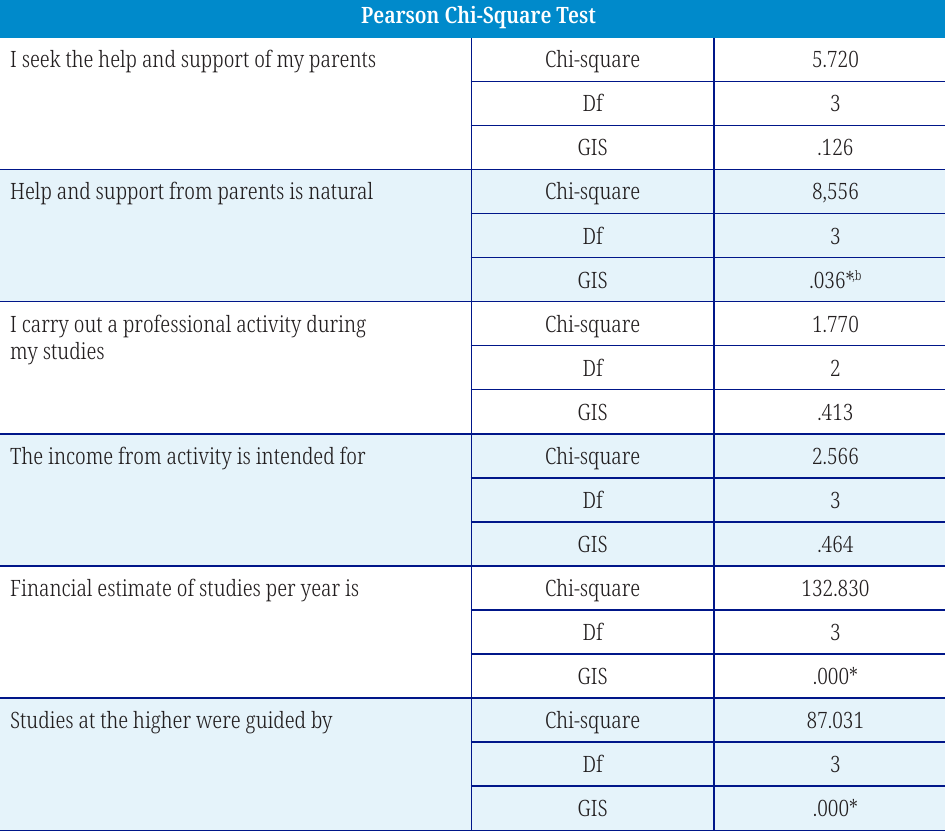
Table 12. Pearson chi-square test: financial and cultural autonomy of public/private university students Pearson Chi-Square